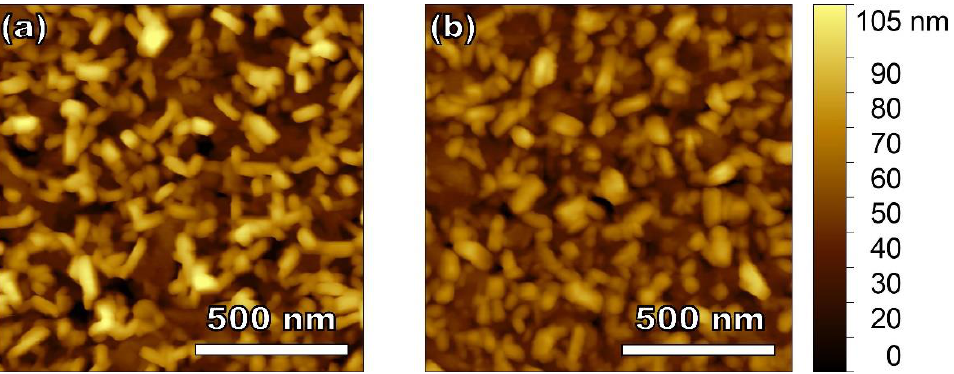
Figure 6. Surface morphology of α -sexithiophene layer deposited on ( a ) bare SiO 2 or ( b ) TTC11P modified